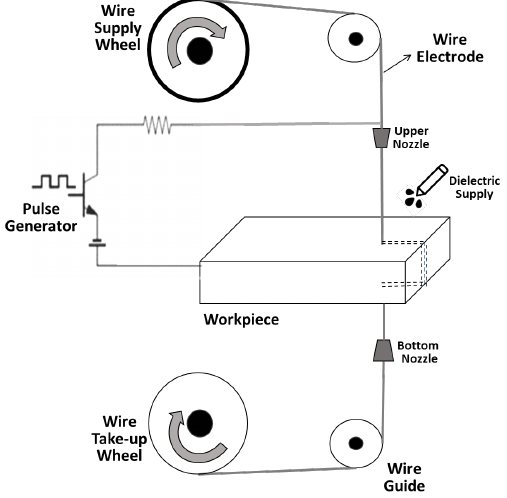
Figure 1. Schematic diagram of